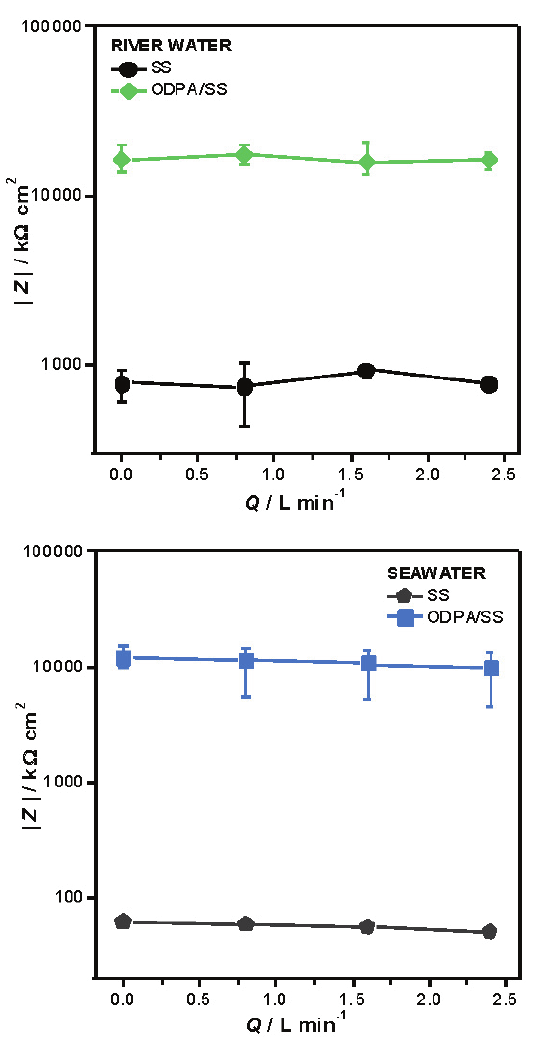
Fig. 7 – Polarization resistance dependence on river and seawater flow rate for untreated and ODPA-modi- fied stainless steel alloy